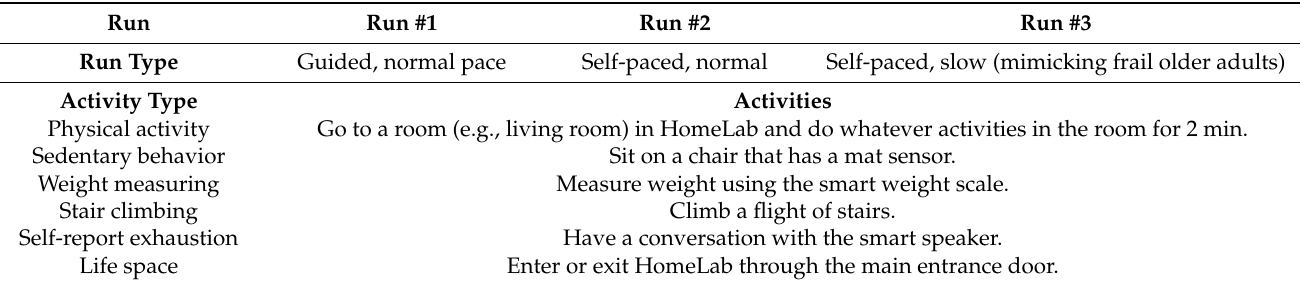
Table 2. Experiment Protocol for Testing the Sensors in